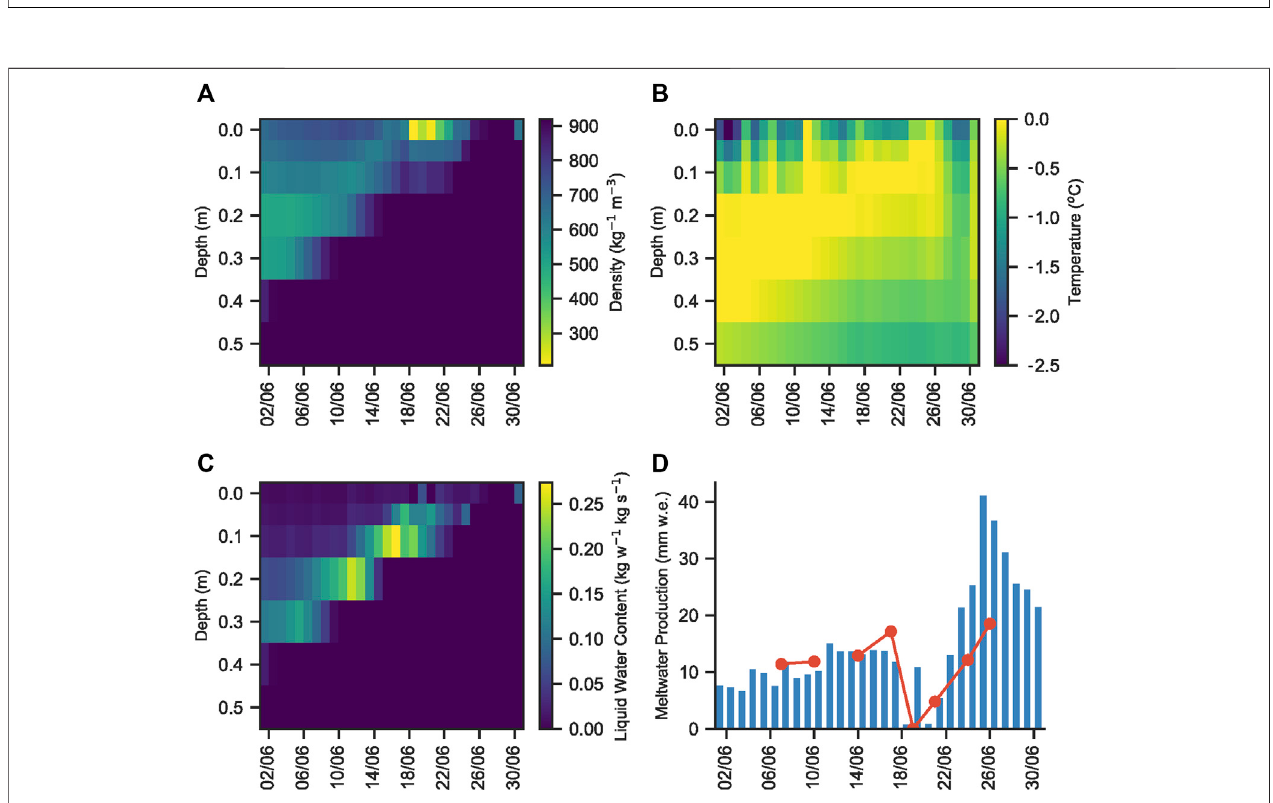
FIGURE7|(A) Modelledsnowandicedensity, (B) temperature, (C) liquidwatercontentand (D) dailymeltwaterproduction,ascalculatedbyMARinthevicinityof S6ontheK-Transect,SWGreenland,fromJune1 – July1.Theredlineonplot (D) showsdailymeltwaterproductioncalculatedusingQuadrant fi vedailysnowpackmelt rate multiplied by an average snow density of 0.6 kg m 3 , as determined from plot (A) .